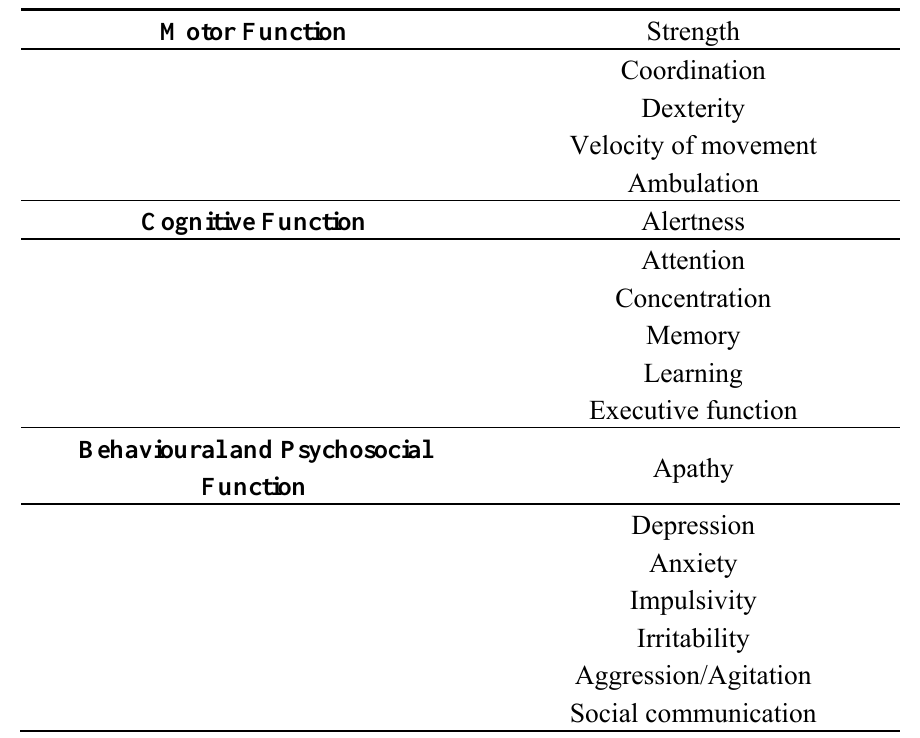
Table 1. Functional impairments frequently encountered after moderate to severe traumatic brain injury during